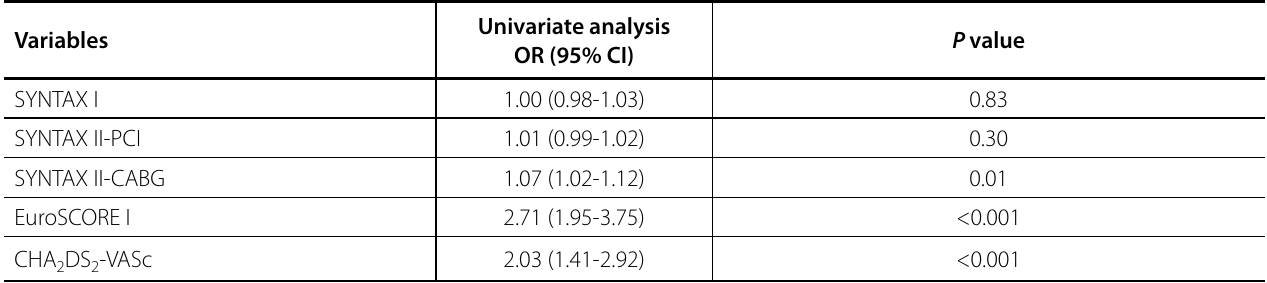
DS -VASc, SYNTAX I, and SYNTAX II scores. 2 2